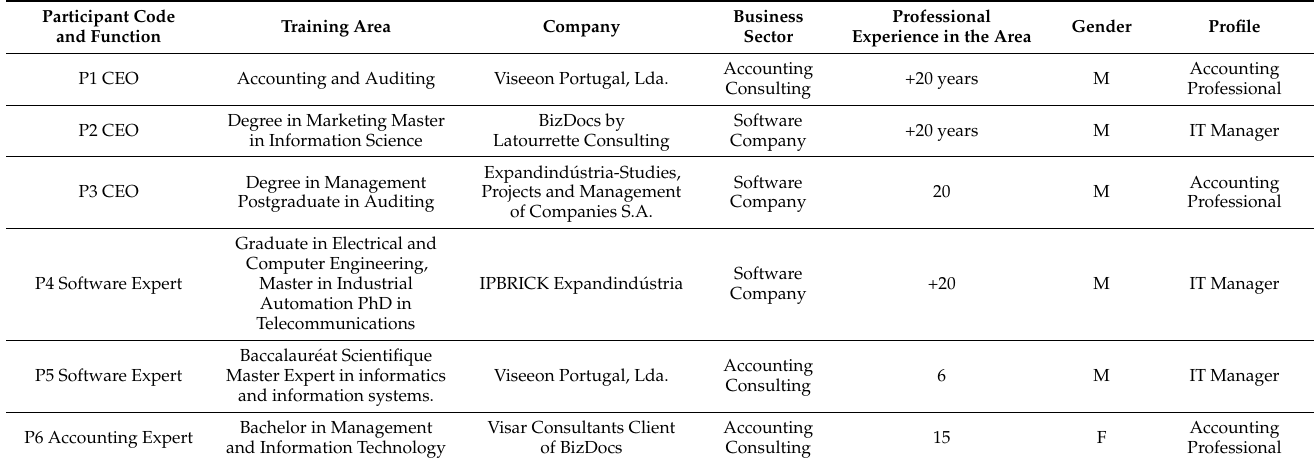
Table 4. Interviewees sample.